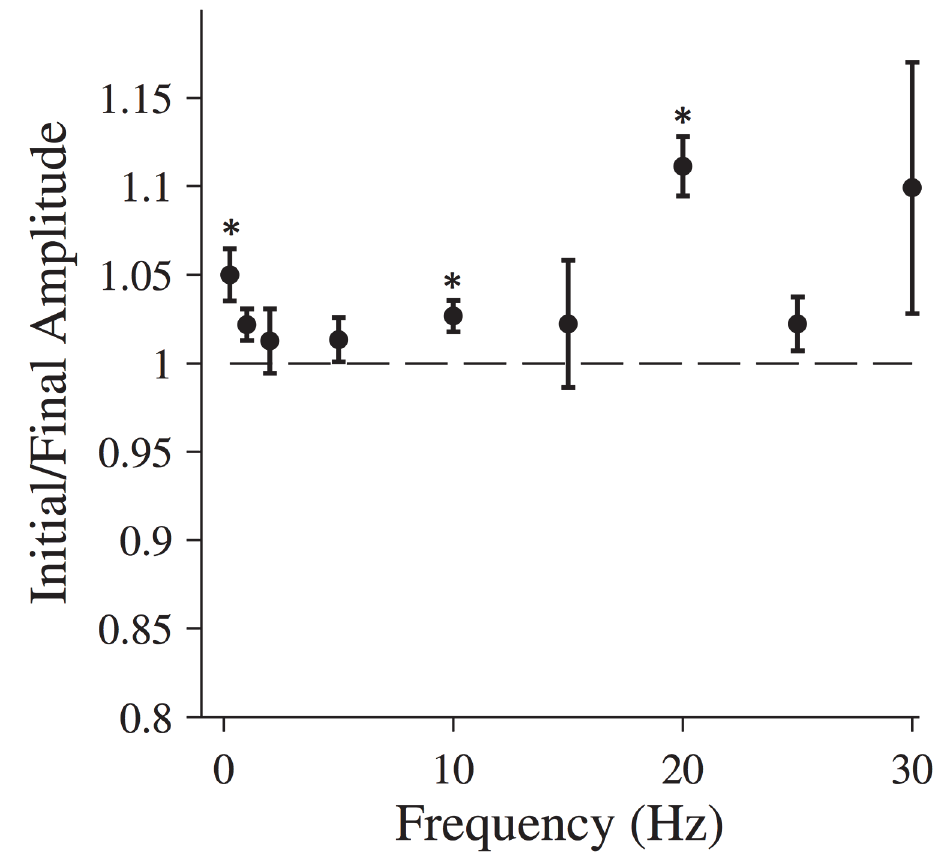
Fig 3. Changing force response for relaxed muscle fibers. The ratio of the initial and final RMS amplitudes for relaxed muscle fibers. The total length of the oscillation was 20 seconds. All data points are (MEAN ± SEM), and the number of fibers analyzed was N = 6. A one-sample t-test was used to test the null hypothesis that data collected at each frequency comes from a normal distribution with mean equal to 1. For data points marked with an asterisk, the null hypothesis was rejected (p <